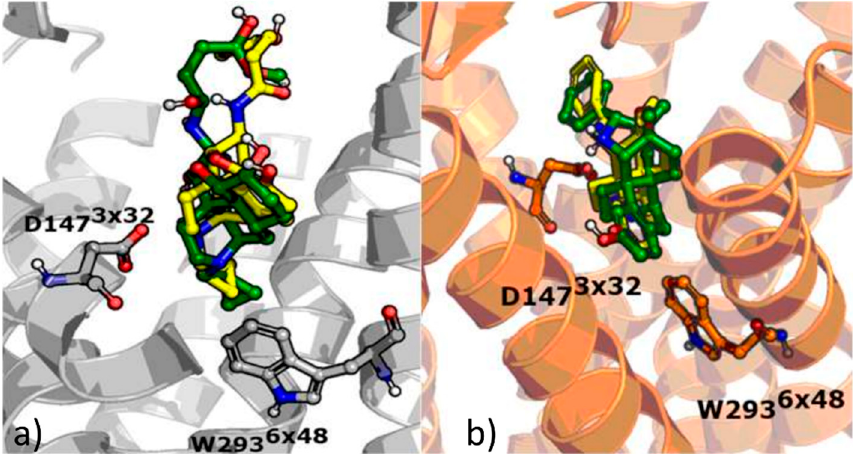
Figure 2. Results of the redocking experiments of co-crystallized ligands BF0 and BU72 to ( a ) 4DKL and ( b ) 5C1M crystal structures—green: co-crystallized conformation, yellow: ligand orientation obtained in docking.